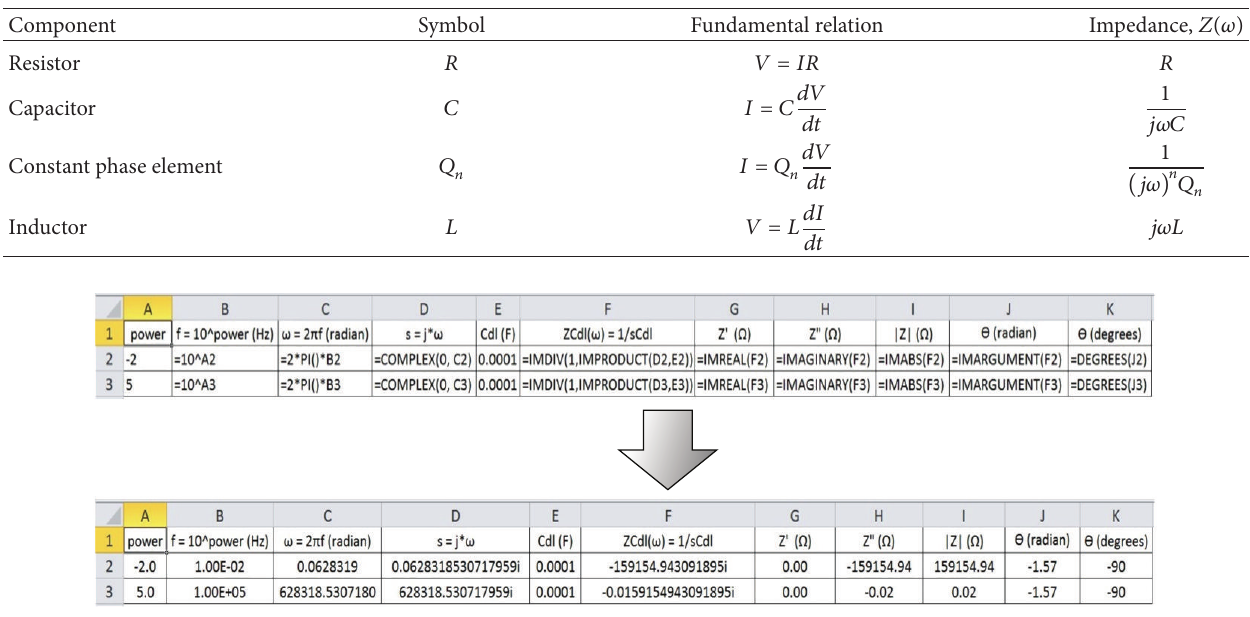
) with capacitance of 100 𝜇 F at frequencies 10mHz and dl